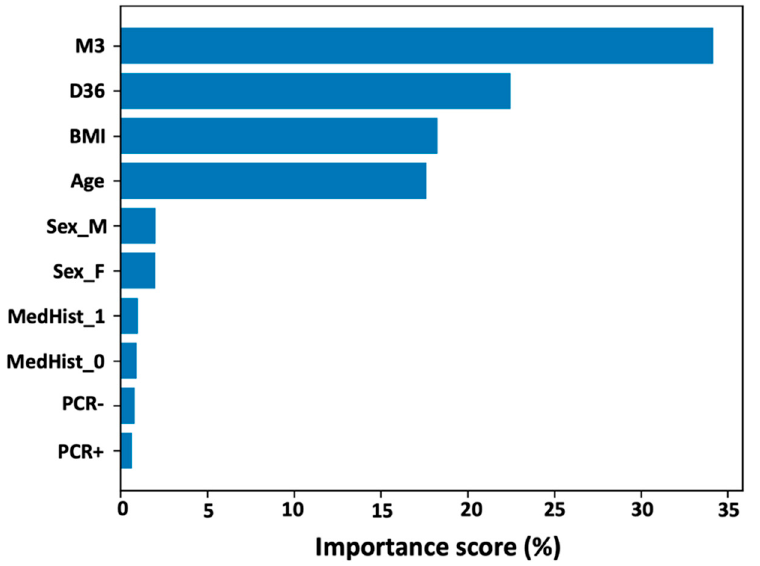
Figure 4. Importance scores for the feature parameters of the subjects participating in the study with regard to their contribution in predicting neutralizing antibody levels nine months after the second vaccination. Key : D36, neutralizing antibody levels two weeks after second vaccination; M3, neutralizing antibody levels three months after second vaccination; BMI, body mass index; MedHist_1, subjects with autoimmune disorders; MedHist_0, subjects without autoimmune disorders; Sex_M, men; Sex_F, women; PCR+, subjects with previous COVID-19 infection; PCR-, subjects without previous COVID19 infection.